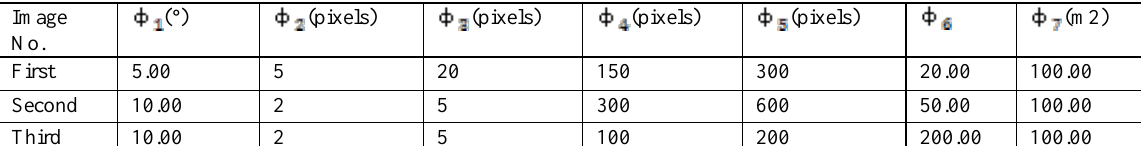
Table 1. The values of the input parameters of our proposed method for the three testing datasets